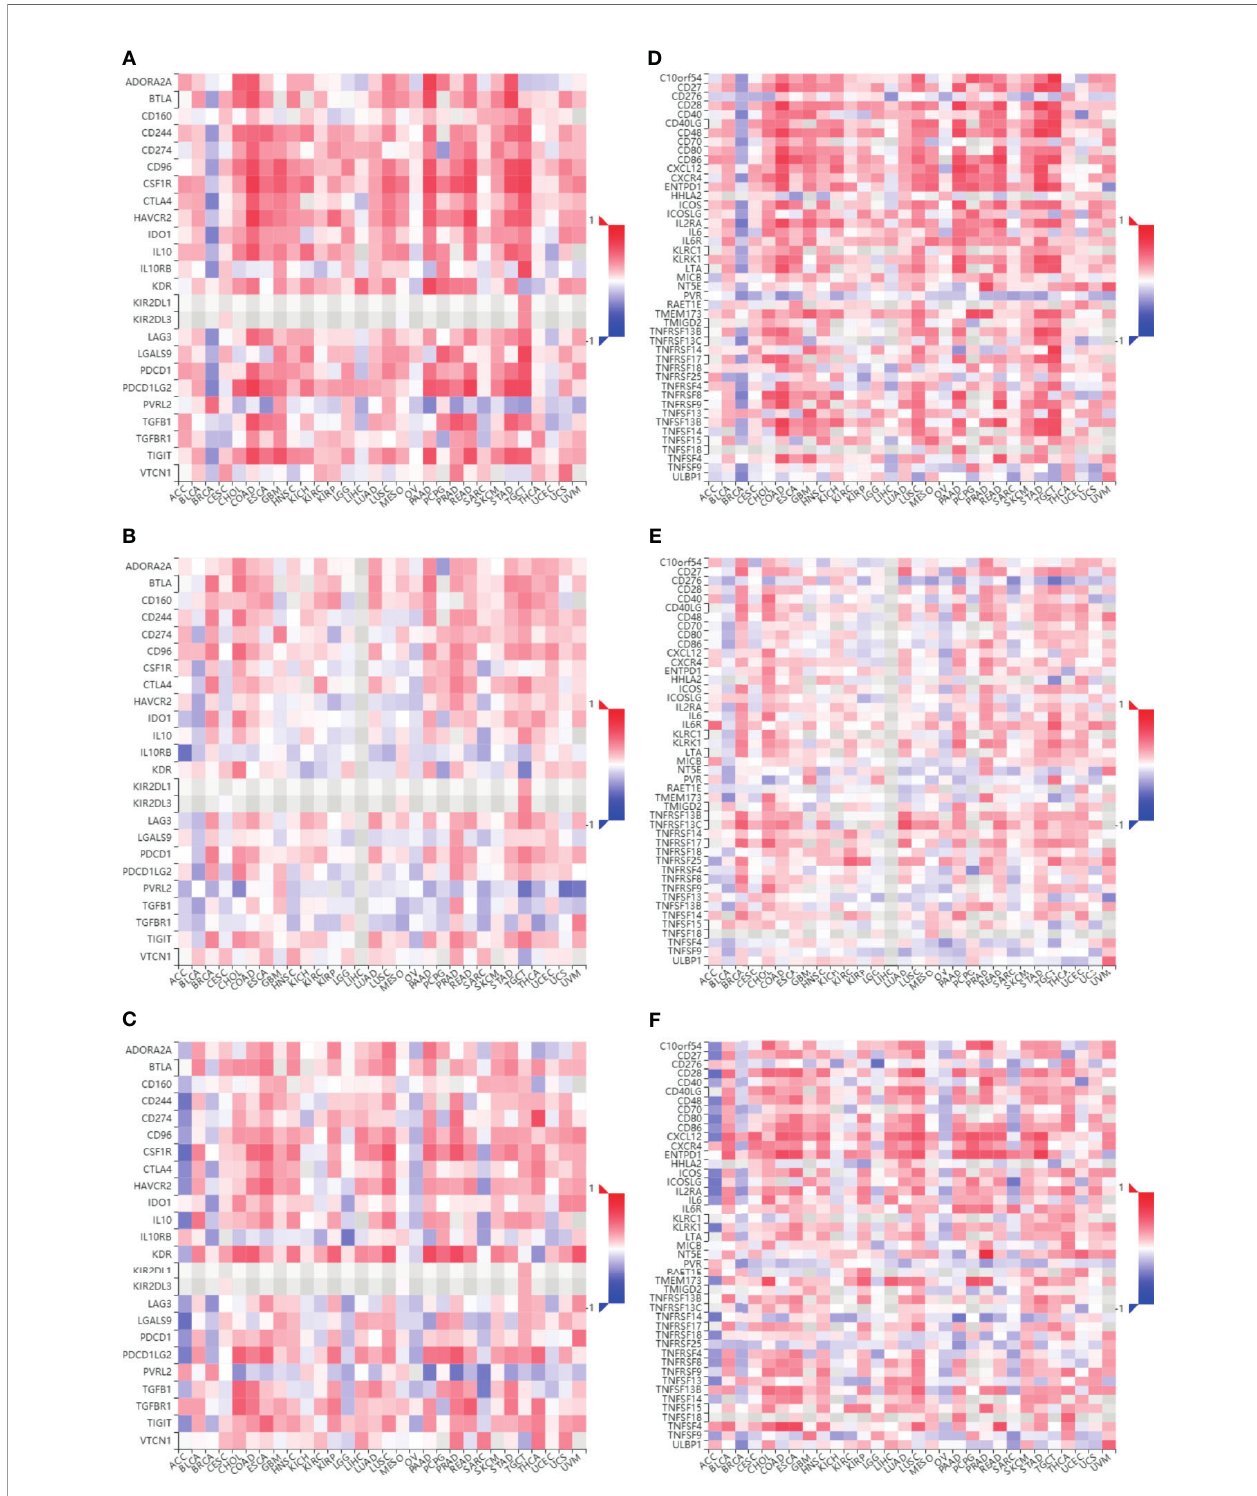
FIGURE 9 | Immunological correlation of ESR1 , ESR2 , and PGR with various cancer immunomodulatory factors. (A) Correlations between ESR1 and immunoinhibitors across multiple cancer types. (B) Correlations between ESR2 and immunoinhibitors across multiple cancer types. (C) Correlations between PGR and immunoinhibitors across multiple cancer types. (D) Correlations between ESR1 and immunostimulators across multiple cancer types. (E) Correlations between ESR2 and immunostimulators across multiple cancer types. (F) Correlations between PGR and immunostimulators across multiple cancer